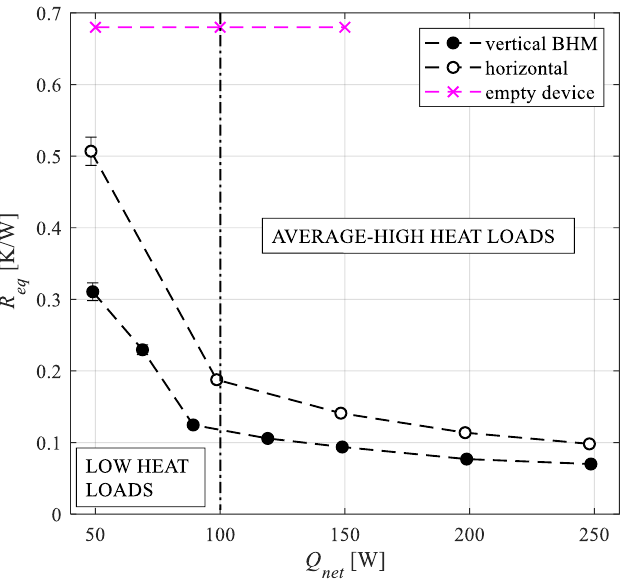
Figure 7. Equivalent thermal resistances of the studied FPPHP.